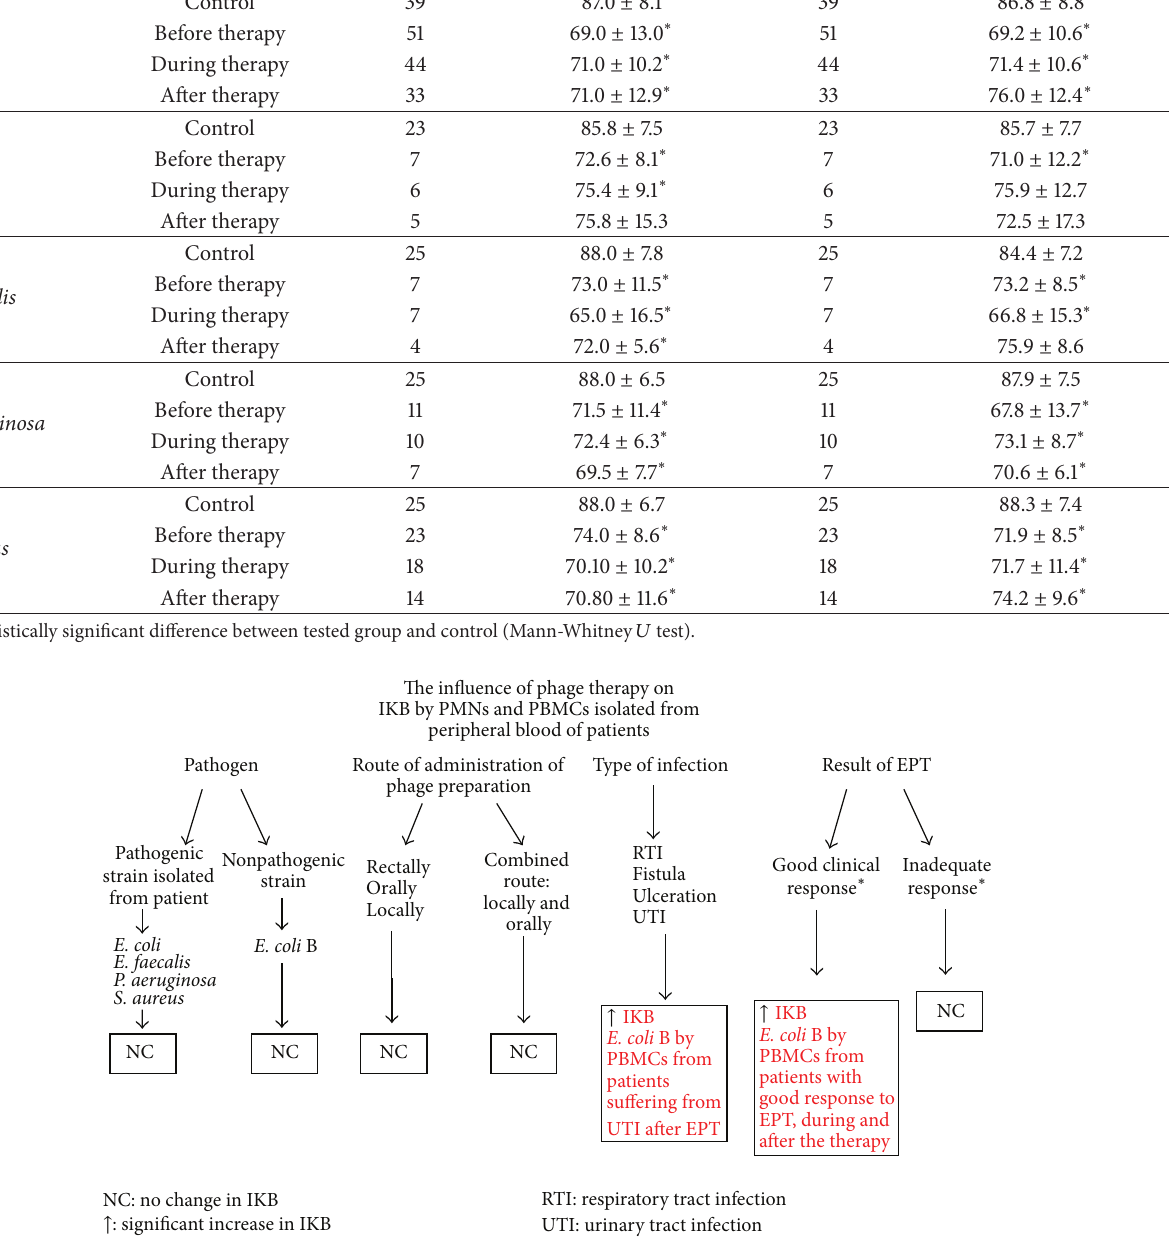
Figure 1: Analysis of the influence of phage therapy on the ability of phagocytes (PMNs and PBMCs) isolated from peripheral blood of patients to kill bacteria intracellularly. ∗ Effectiveness evaluation of EPT according to Międzybrodzki et al. (2012) [14].